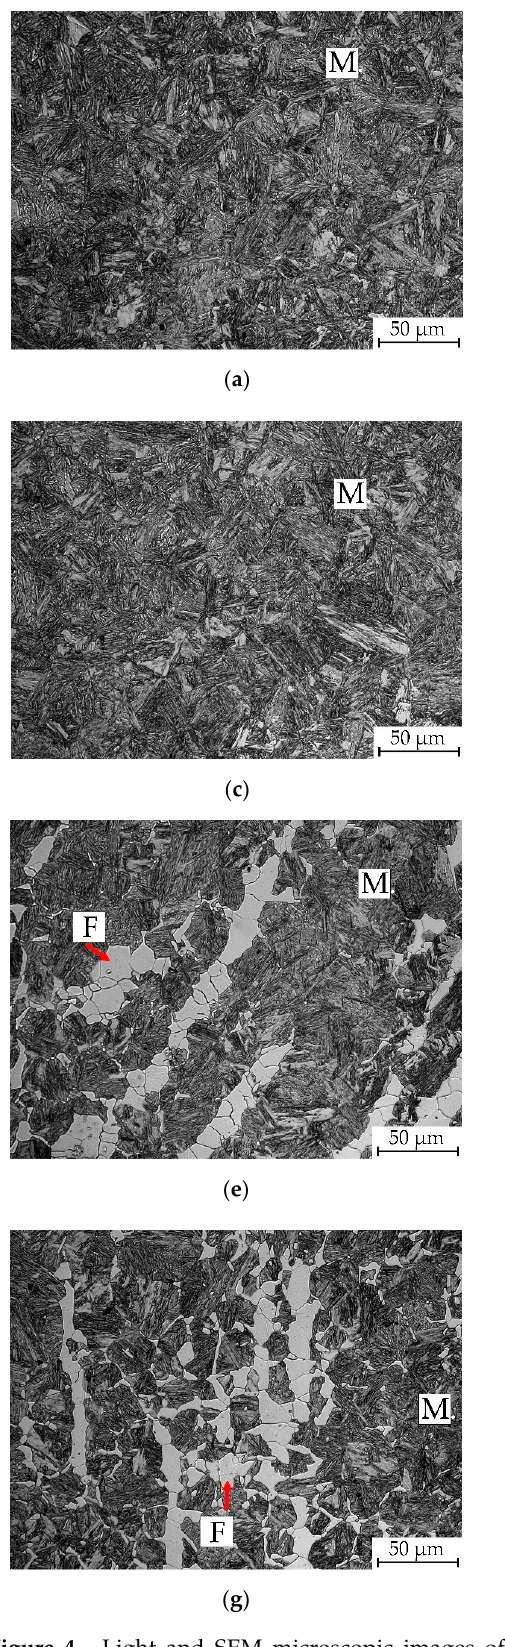
Figure 4. Light and SEM microscopic images of non-deformed samples: ( a , b ) sample 600ND; ( c , d ) sample 650ND; ( e , f ) sample 700ND; ( g , h ) sample 750ND; M—martensite; F—ferrite. Table 3. Experimental results of non-deformed samples.